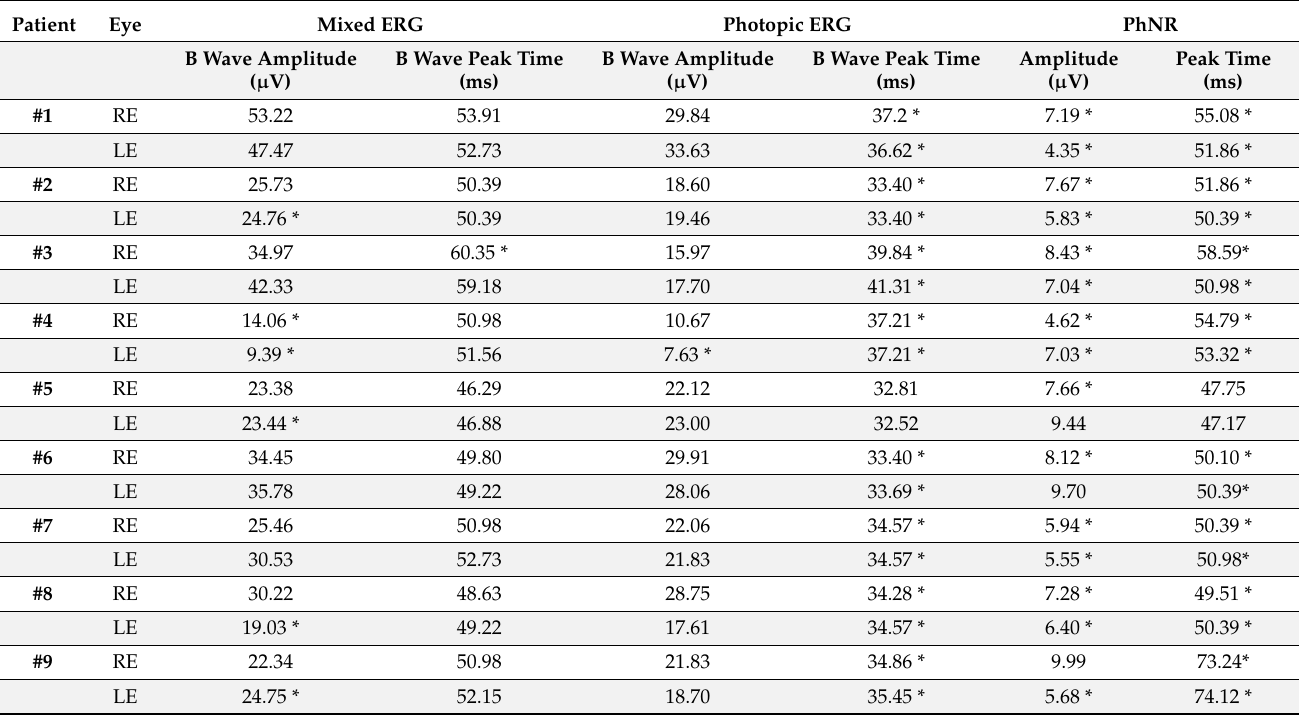
Table 4. Electroretinogram results.